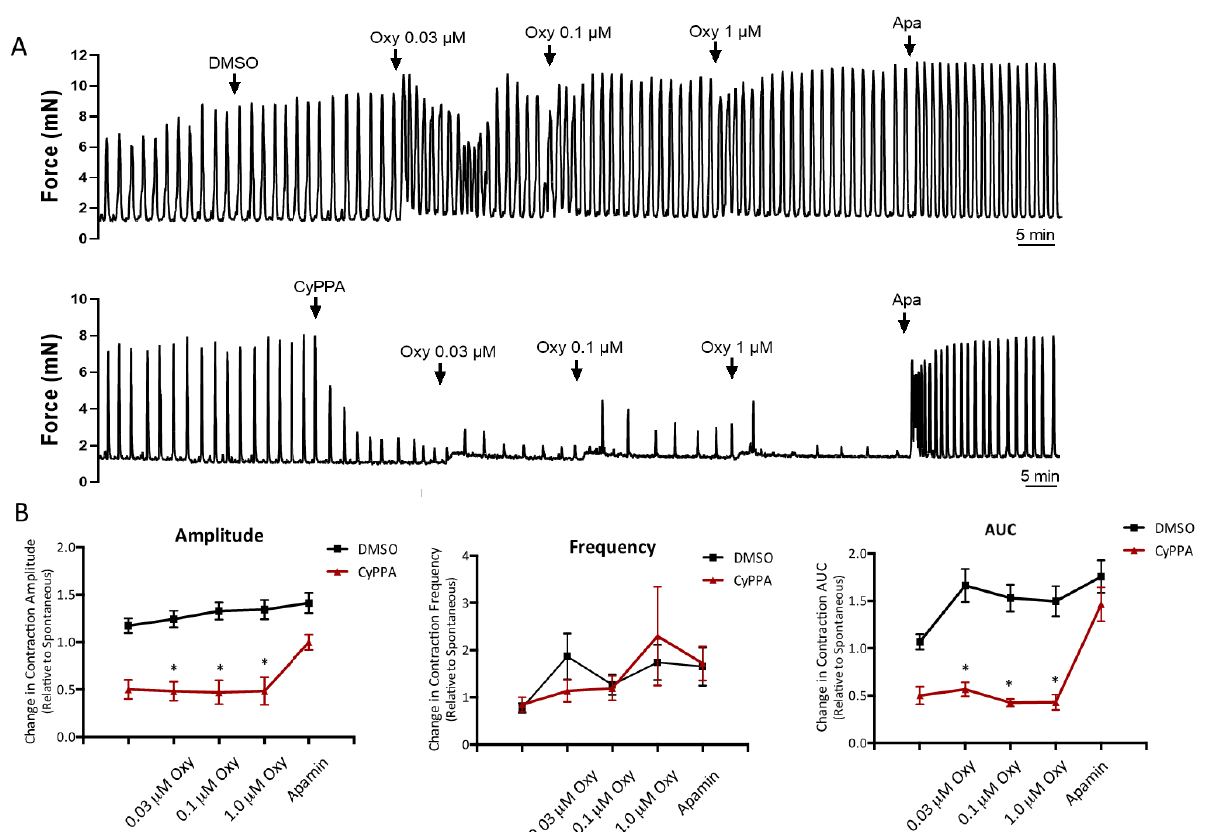
Figure 1. Oxytocin-induced contractions of isolated uterine strips in the presence or absence of CyPPA. ( A ) Panels show representative myography recordings of strips treated with either 10 µ M CyPPA or 0.05% DMSO vehicle and subsequently stimulated with increasing concentrations (0.03–1 µ M) of oxytocin. Finally, strips were exposed to the K Ca 2 inhibitor apamin (0.6 µ M). ( B ) Summary plots show cumulative effects of treatments on contraction amplitude, frequency, and area under curve (AUC). Asterisk (*) indicates p < 0.05 vs. DMSO; (n = 7).